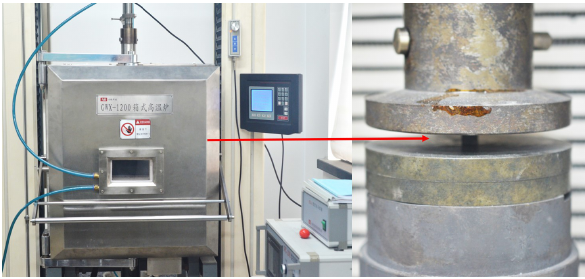
Figure 5: High temperature compression experiment